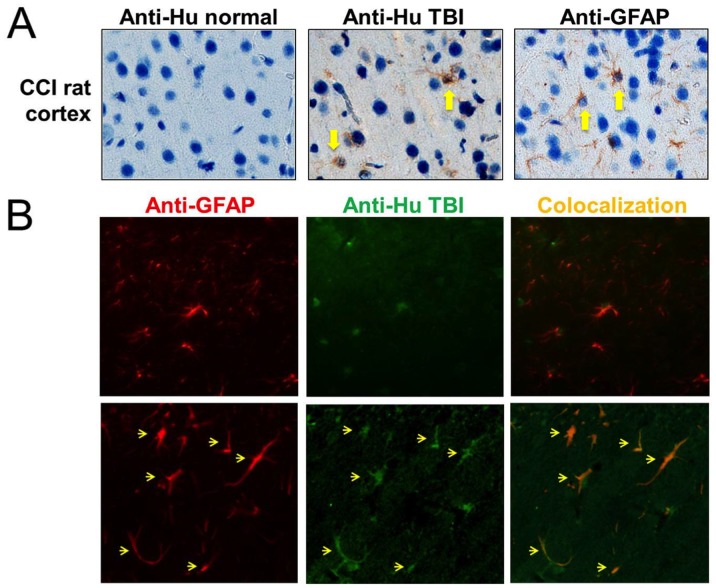
TBI autoantibodies labeled GFAP in injured rat brain.
A. In sections of cortex from rats injured by CCI, anti-GFAP antibody (Cell Signaling) or human Day 10 TBI serum showed similar patterns of immunoreactivity (brown), while human normal serum did not. Nuclei are blue. B. Sections of hippocampus from naïve or CCI-injured rats were incubated with anti-GFAP antibody (Cell Signaling) plus human Day 10 TBI serum, and bound antibodies were visualized with fluorescent secondary antibodies (anti-GFAP in red, TBI serum in green). Image contrast was adjusted in the panels individually to best display the fluorescence. In naïve hippocampus, TBI autoantibodies showed little binding, while in CCI hippocampus, anti-GFAP antibody and TBI autoantibodies showed increased immunostaining, which partially colocalized (orange, arrows).